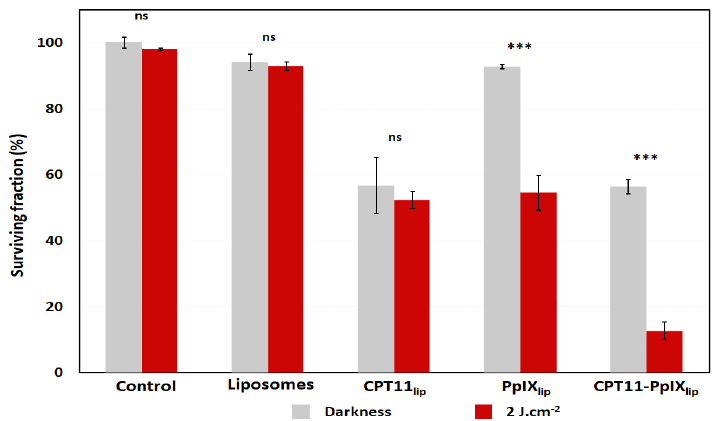
Figure 1. Cell viability of HeLa cells treated with unimodal and bimodal liposomal formulations in darkness and light conditions. Irradiation was performed with a red-light dose of 2 J · cm − 2 . Cell viability was analyzed by MTT assay performed 24 h after each treatment. p values < 0.001